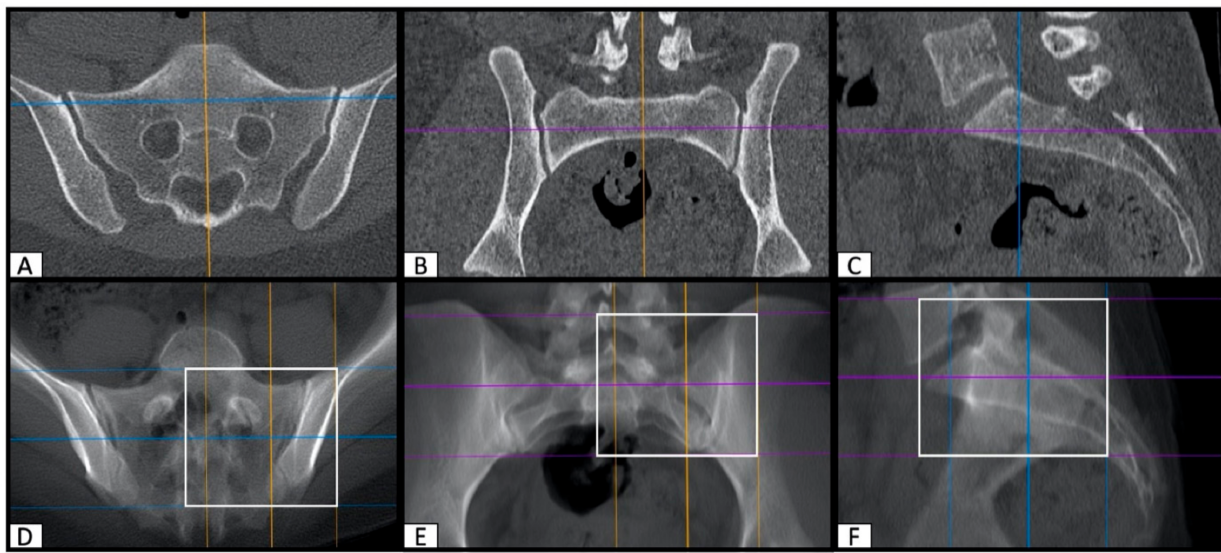
Figure 2. Symmetric orientation of the CT scans using the multi-planar reconstruction function of Osirix MD in axial and coronal orientations ( A , B ) to create an exact lateral view ( C ). Marking the region of interest (white box) and fusion of this area by means of the thick slab function ( D – F ) of OsiriX MD to create a two-dimensional exact lateral image of the sacrum ( F